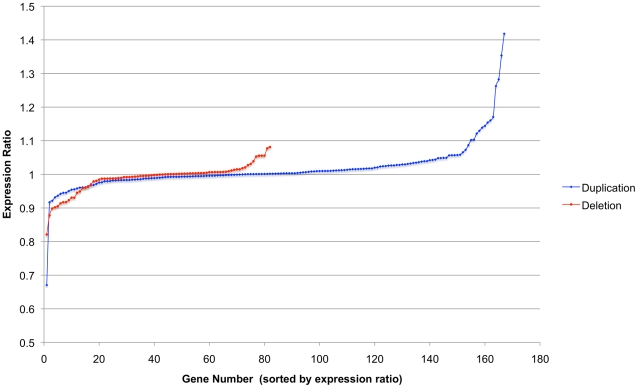
Expression ratio for each type I gene.Expression ratios (normalised expression) for each duplicated and deleted type I genes. Note that although there are more duplicated genes with higher expression ratios the vast majority of both duplicated and deleted genes have an expression ratio very close to one rather than the 0.5 (1 copy) or >1.5 (>3 copies) expected. These distributions are similar to those of Supplemental figure S1.